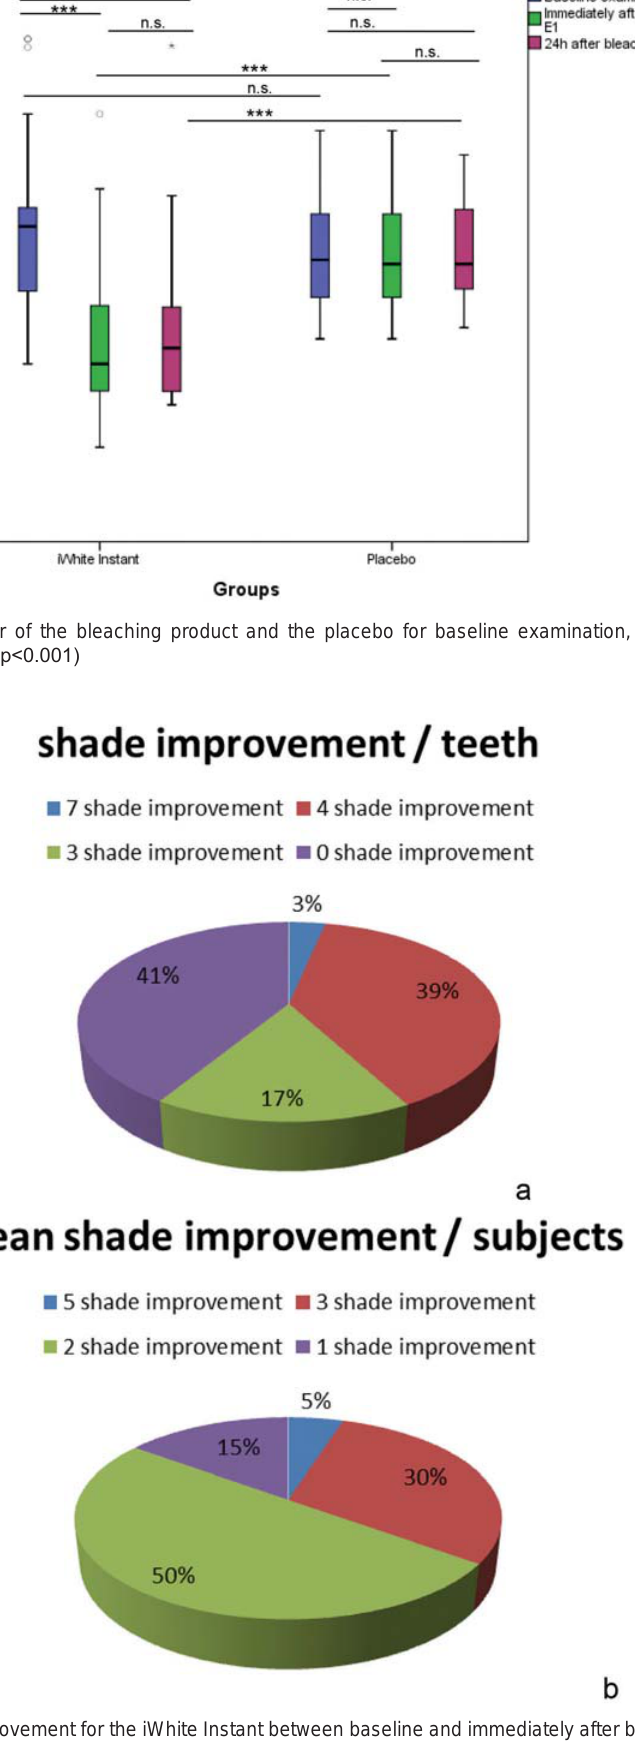
Figure 4- Distribution of shade improvement for the iWhite Instant between baseline and immediately after bleaching (a) per teeth (b) per